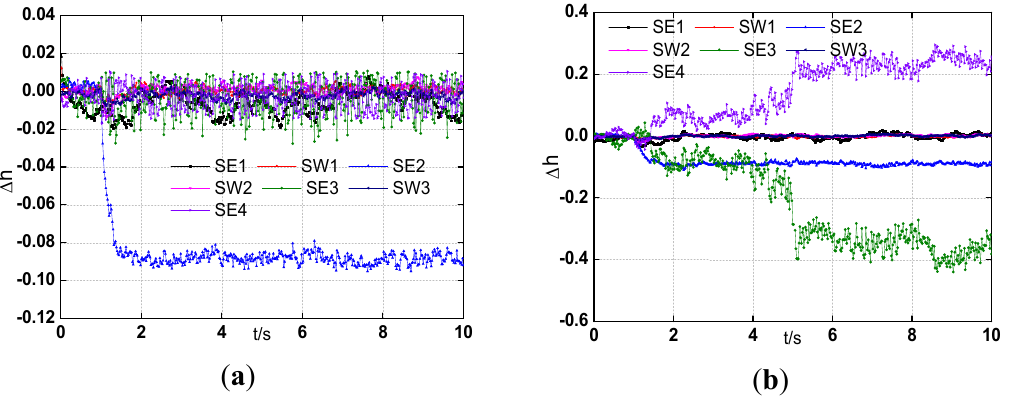
Figure 9. Health parameters estimation with all measurements except P5 in Gaussian system under the Fault 1. ( a ) The cEKPF; ( b ) the